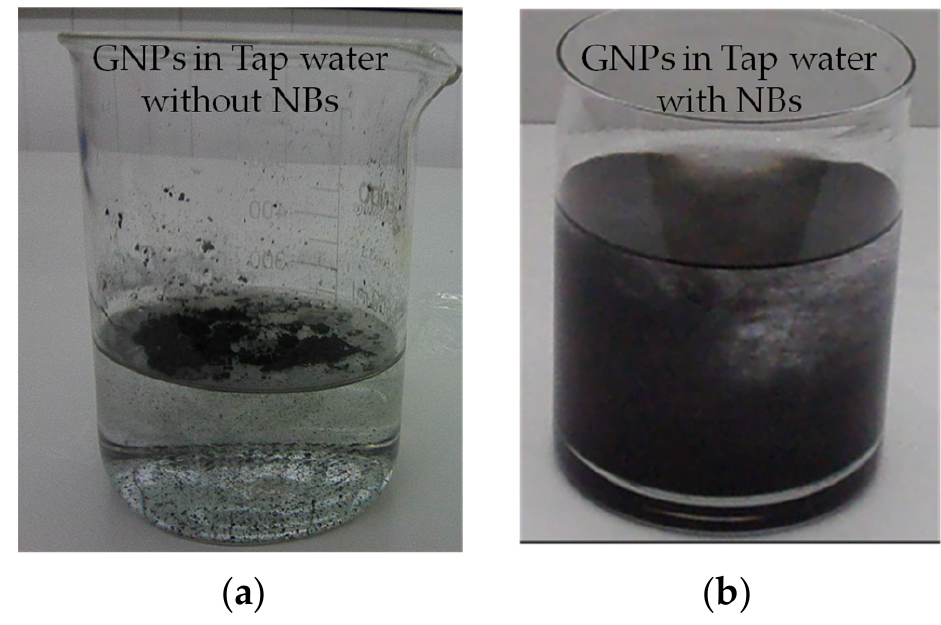
Figure 2. GNP suspensions in ( a ) plain tap water and ( b ) tap water with nanobubbles.